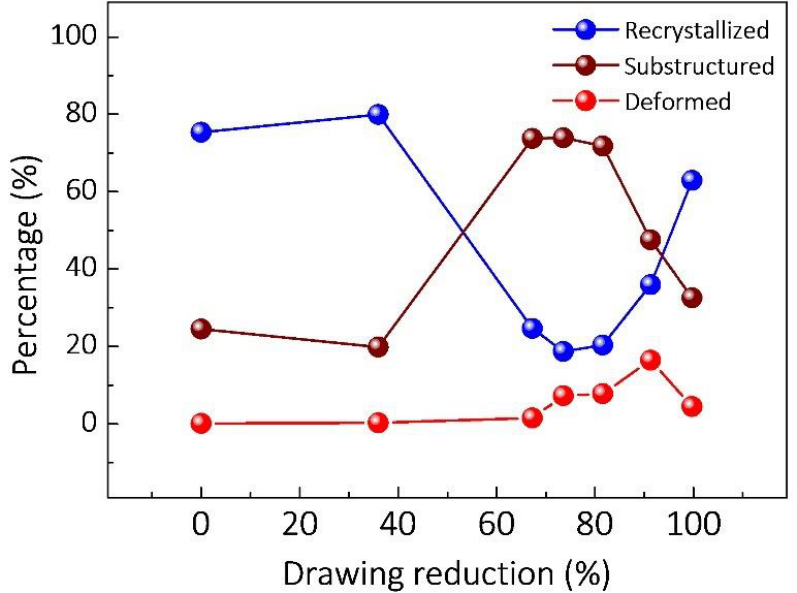
Figure 9. The percentage of recrystallized, substructured, and deformed grains of the as-drawn composites with different drawing reductions.